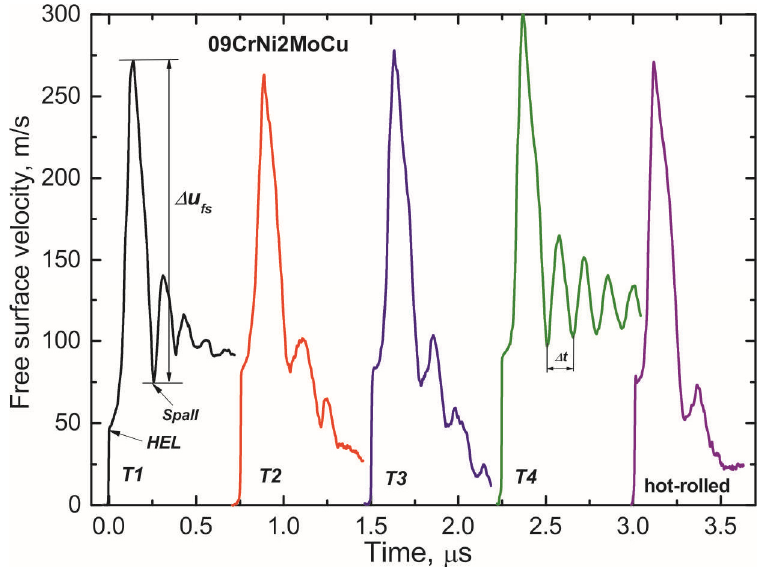
Figure 6. Free surface velocity profiles of 09CrNi2MoCu steel samples obtained by DLD method and hot rolling after different heat treatment.